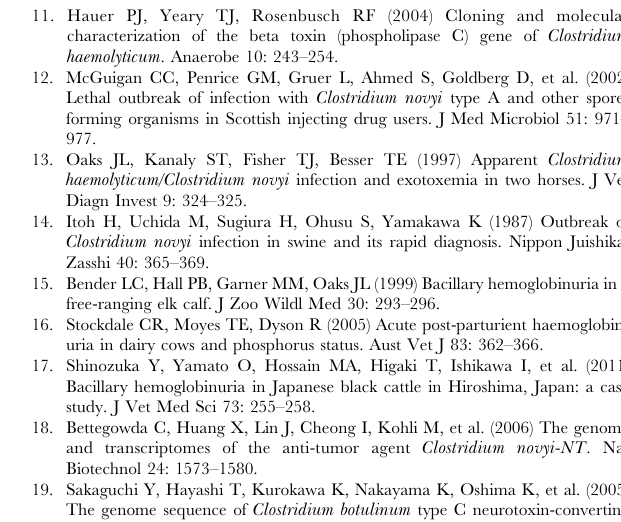
Figure S3 Similarity matrix showing the core sizes (40% normalized BLASTN score threshold) between C. novyi sensu lato plasmids. The full similarity matrix corresponding